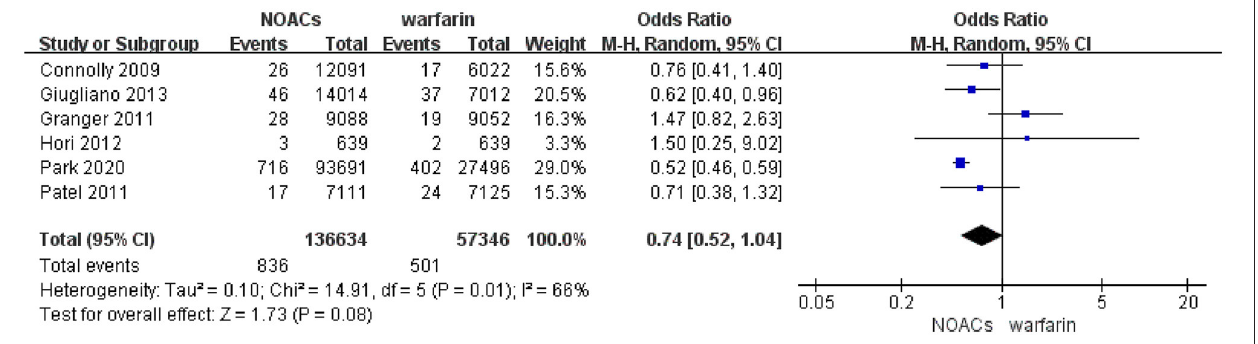
FIGURE 2 | Forest plot of intraocular bleeding events in patients with AF with NOACs vs. warfarin using the random-effects model. NOACs, novel oral anticoagulants; CI, confidence